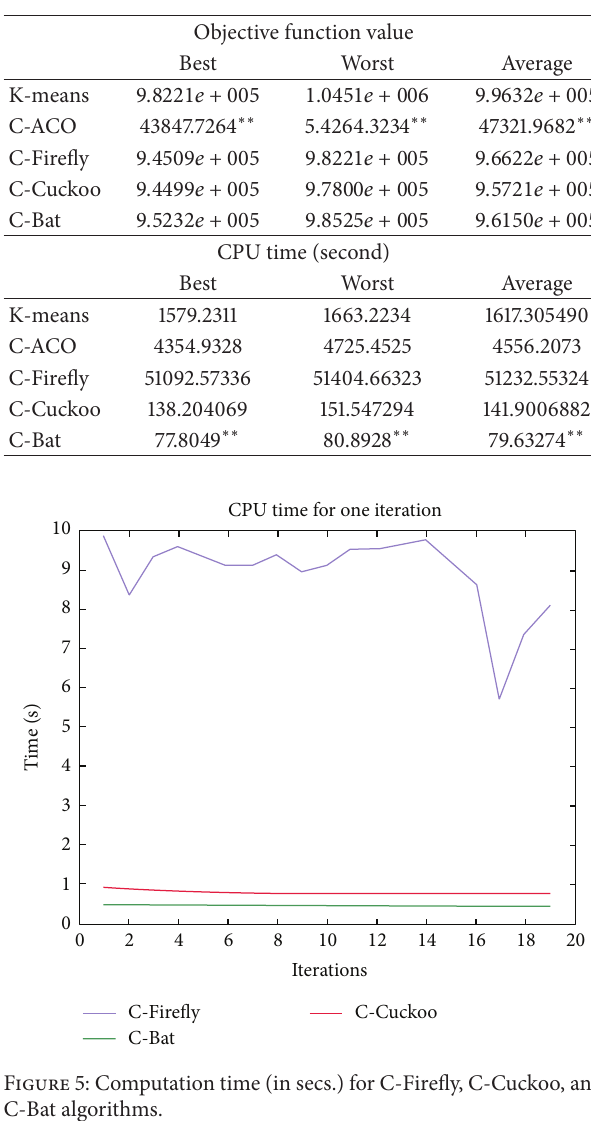
Table 8: Testing objective function fitness and CPU time consump- tion on wine.